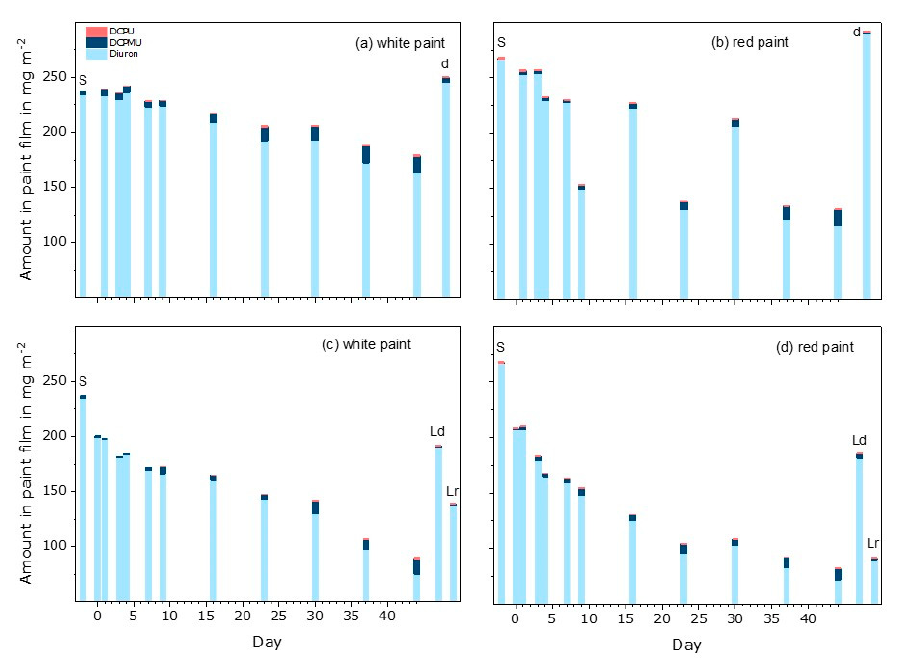
Figure 7. Amounts of diuron and transformation products detected in paint extracts. Upper row: test specimens were exposed to UV radiation at 40 ◦ C; lower row: test specimens were exposed to UV radiation at 40 ◦ C and water contact during immersion cycles. Extraction was performed after the immersion cycles. S: original amount detected in test specimens before start, d: test specimen was reversed in the sample holder, Ld: leaching test was performed with test specimens that were reversed in the sample holders (1 immersion cycle), Lr: leaching test was performed with test specimens that were stored at room temperature in the dark (10 immersion cycles). Each column represents mean values from two independently analyzed test specimens. Inconsistent data for diuron between 9 and 30 days for the red paint after UV radiation (upper row) are probably explained by outliers.